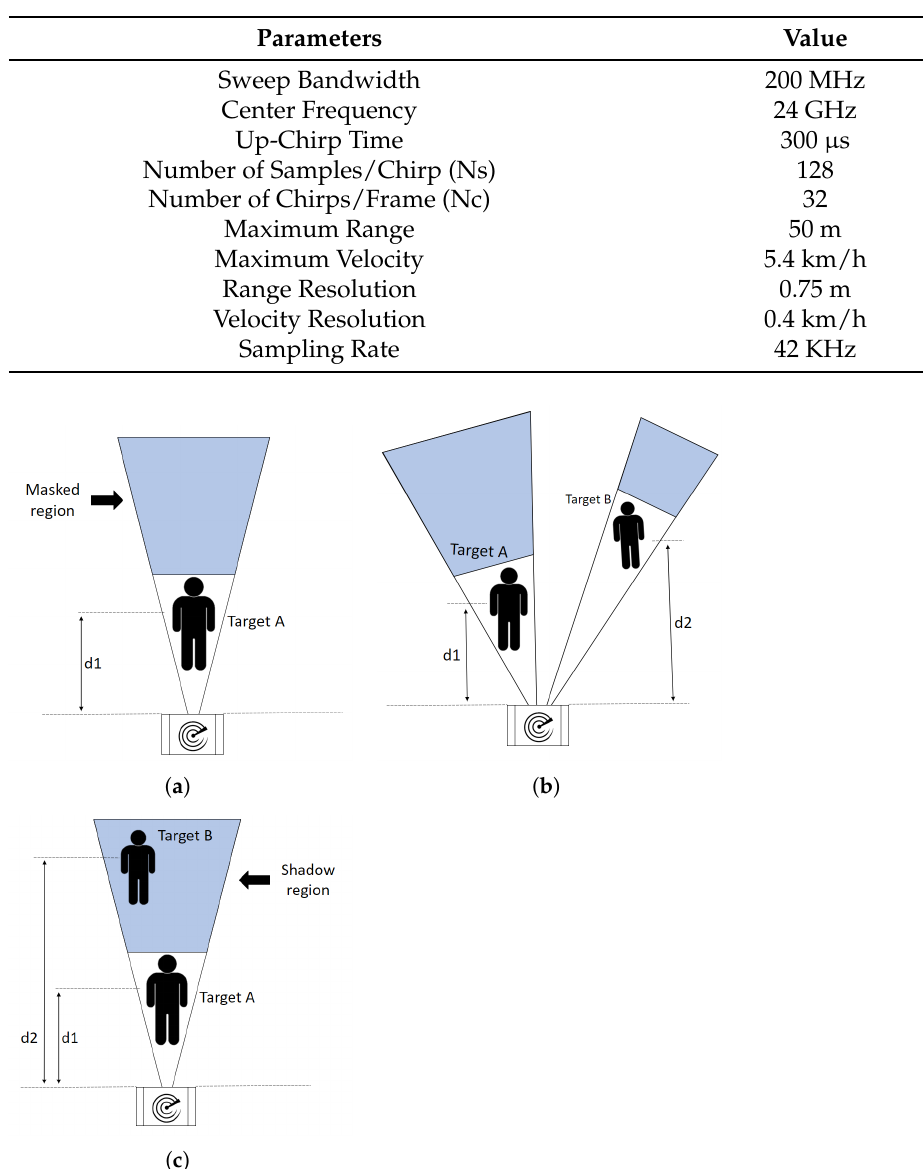
Table 1. Position2Go radar specifications.